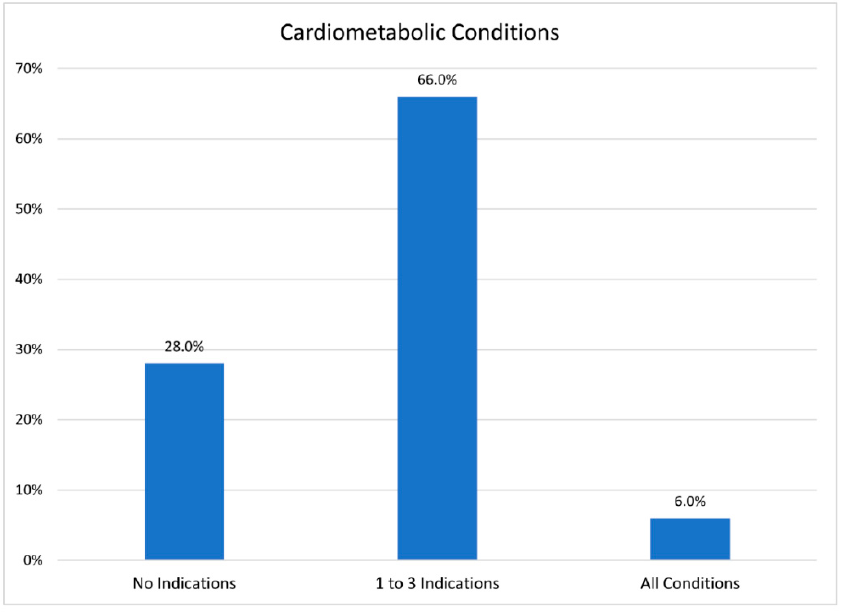
Figure 7. Participants’ Cardiometabolic Conditions.